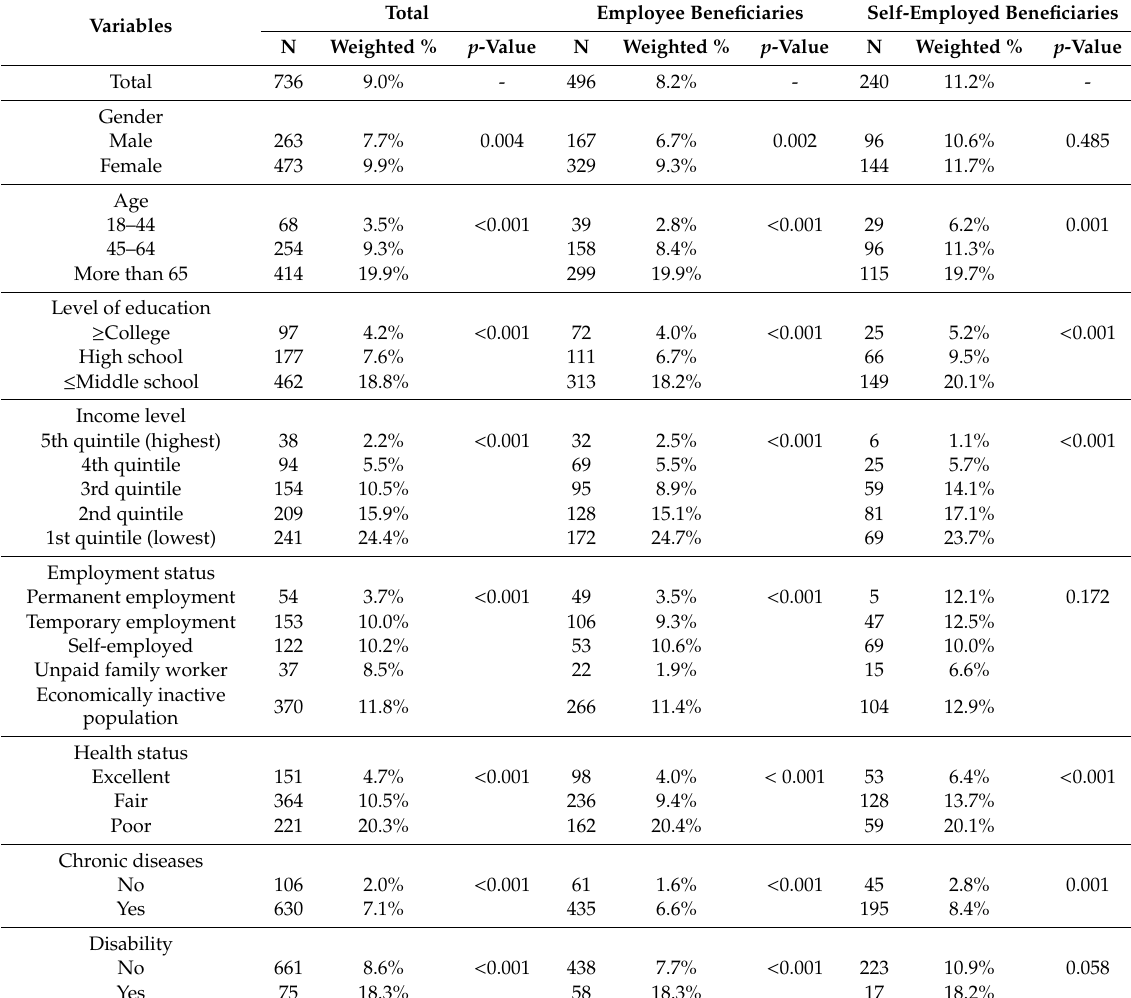
Table 2. The di ff erent rates of unmet dental needs and those due to economic burdens between the type of NHI beneficiary, 2015.